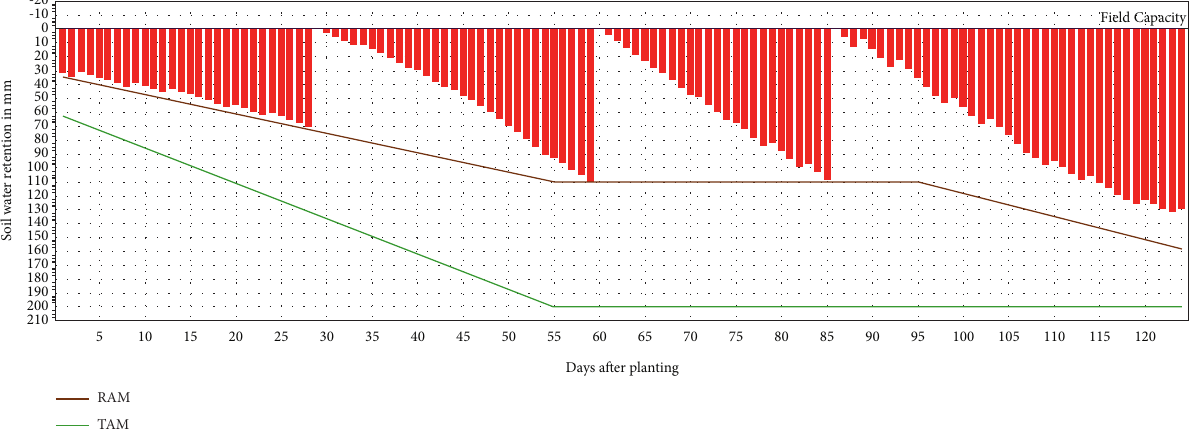
Figure 6: Color reveals the maize irrigation schedules showing RAM (brown line); TAM (green line); and water depletion (red vertical line